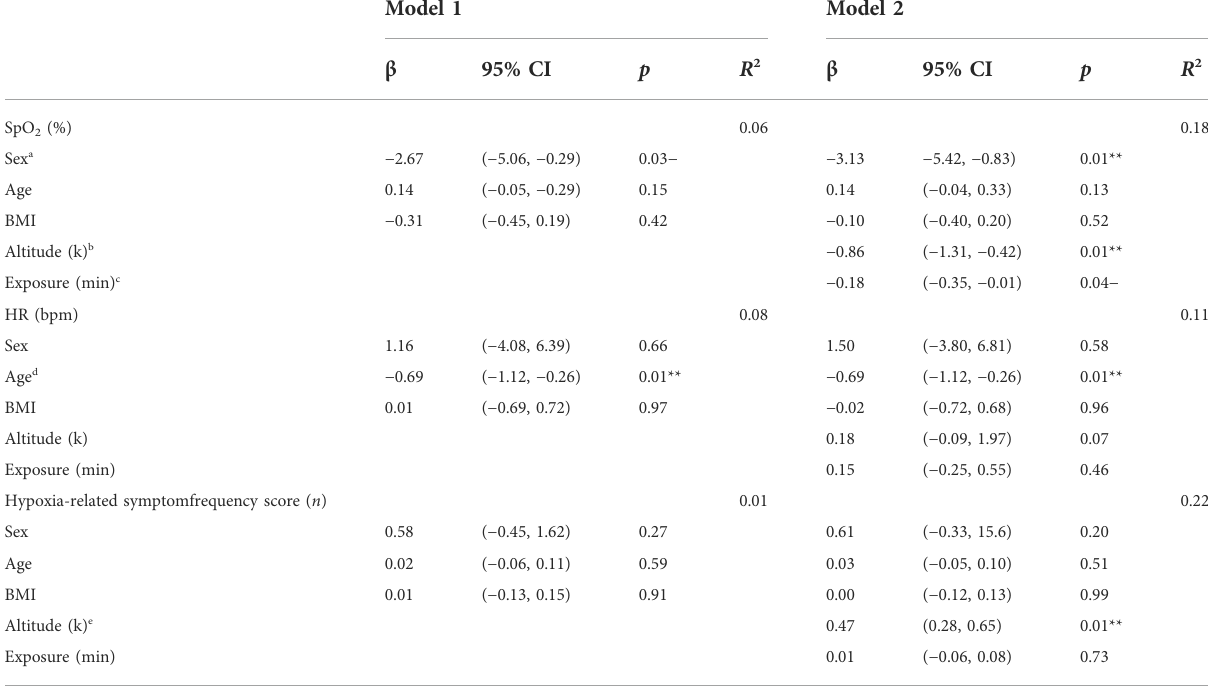
TABLE 3 Linear regression models of physiological and self-reported hypoxia-related symptom frequency outcomes. Model 1